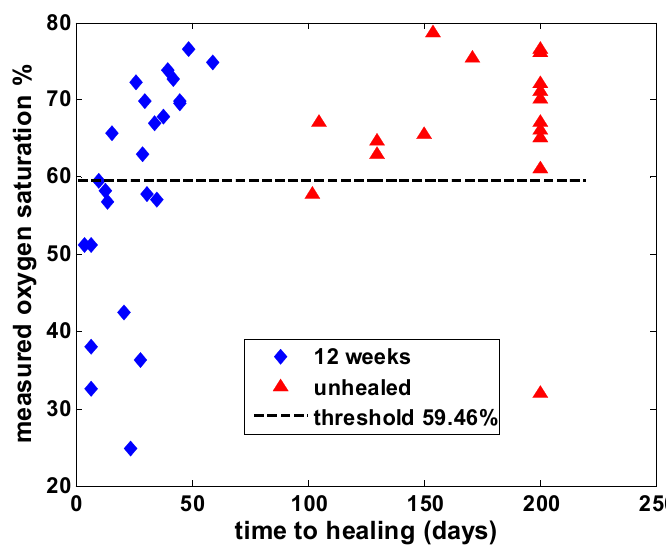
Figure 3. Relationship between time to healing (days) and oxygen saturation in a region adjacent to the wound. In order to plot unhealed ulcers, their healing days were set at 200 (higher than all the healing days of the healed ulcers). The dashed line represents the optimum threshold calculated from Youden’s index.